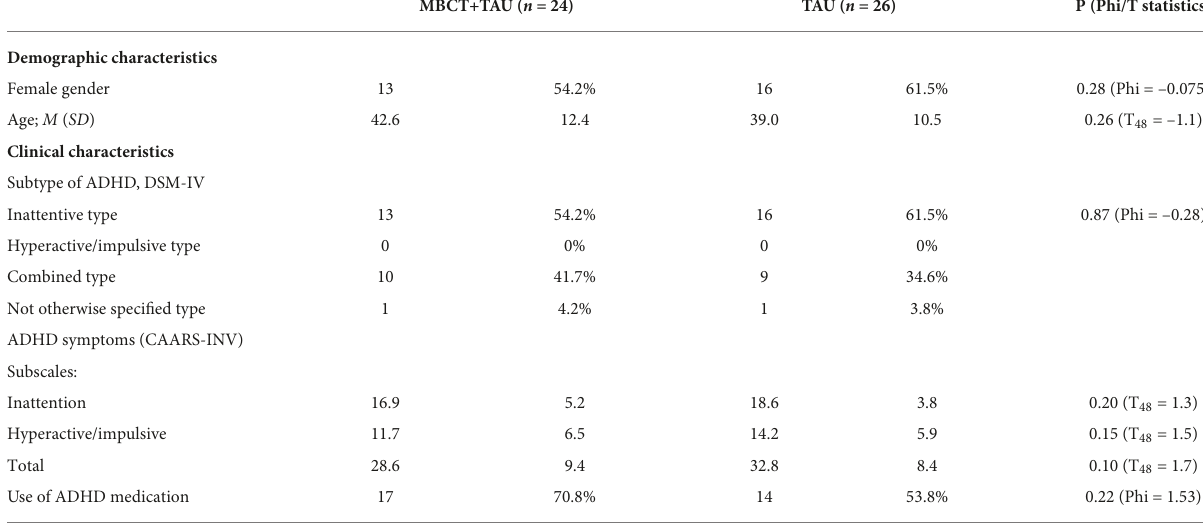
TABLE 1 Baseline demographic and clinical characteristics.